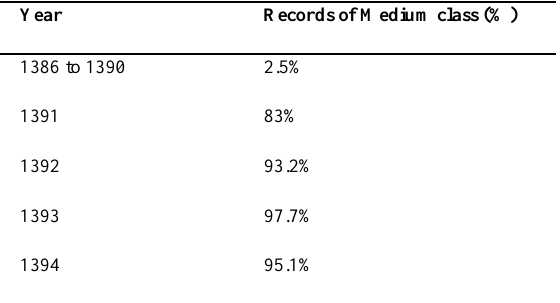
Table 16. Melat Bank performance.